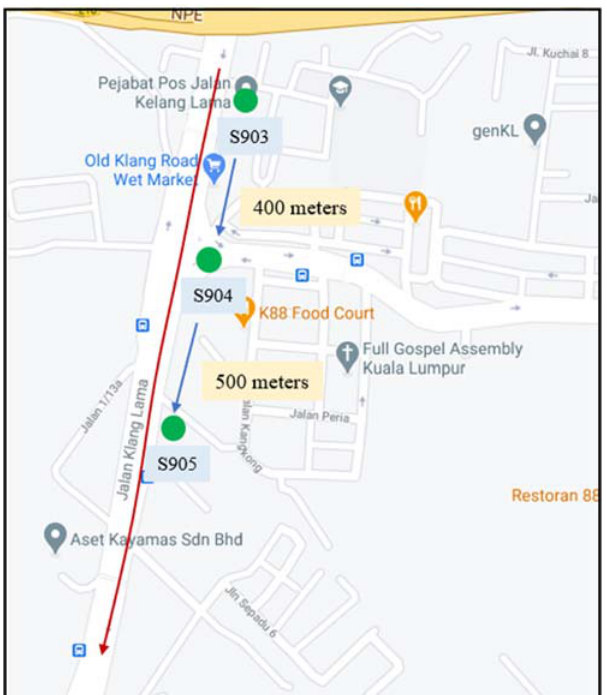
Figure 3: The location of the case study in Kuala